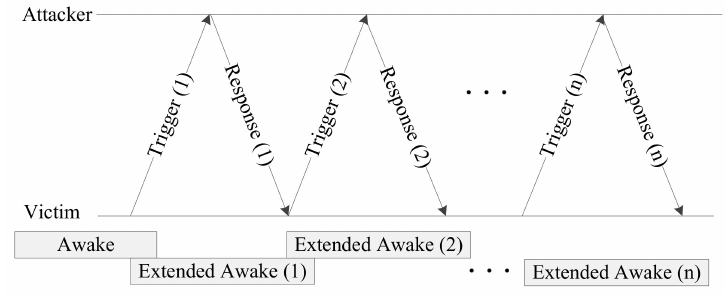
Figure 6. Awaken time extension analysis.